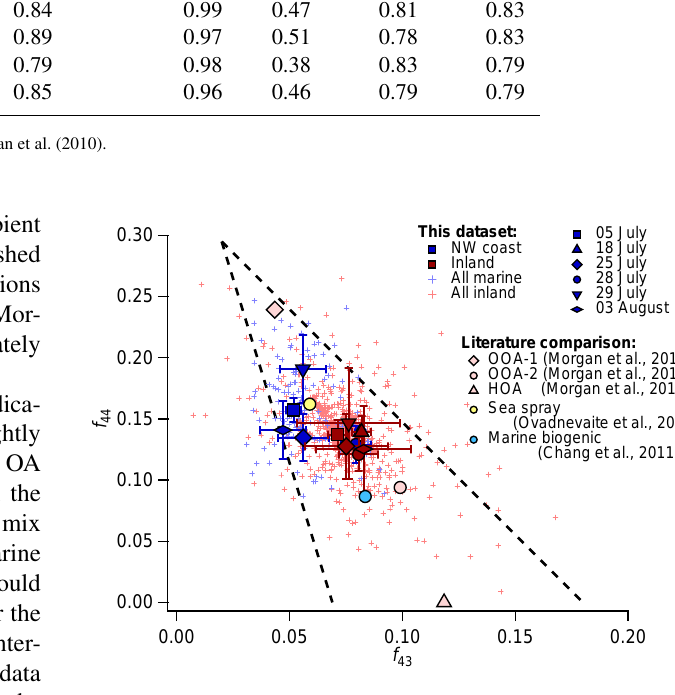
Figure 7. Relationship between the fraction of OA signal at ( m/z ) = 44 and 43, in coastal and inland areas. The diagonal dot- ted lines define the region where ambient OOA measurements tend to fall (Ng et al., 2010). The data points labelled “All marine” are the NW coast data from 5, 25, and 29 July and 3 August, whereas the points labelled “All inland” are from all six flights. The literature spectra are the same as those in Table